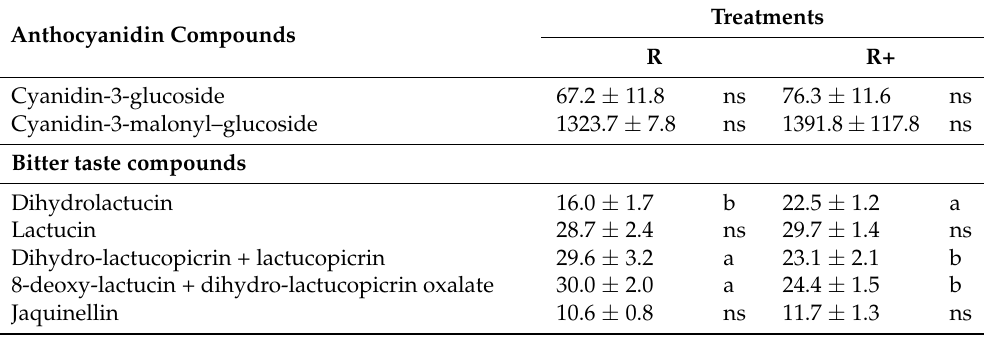
Table 5. Main anthocyanidins and bitter taste chemical compounds (mg kg − 1 ) in the dry biomasses of monocultured and intercropped red chicory. Different letters indicate significant differences ( p < 0.05) among treatments for each parameter, according to the Tukey’s HSD test. ns = not significant differences.